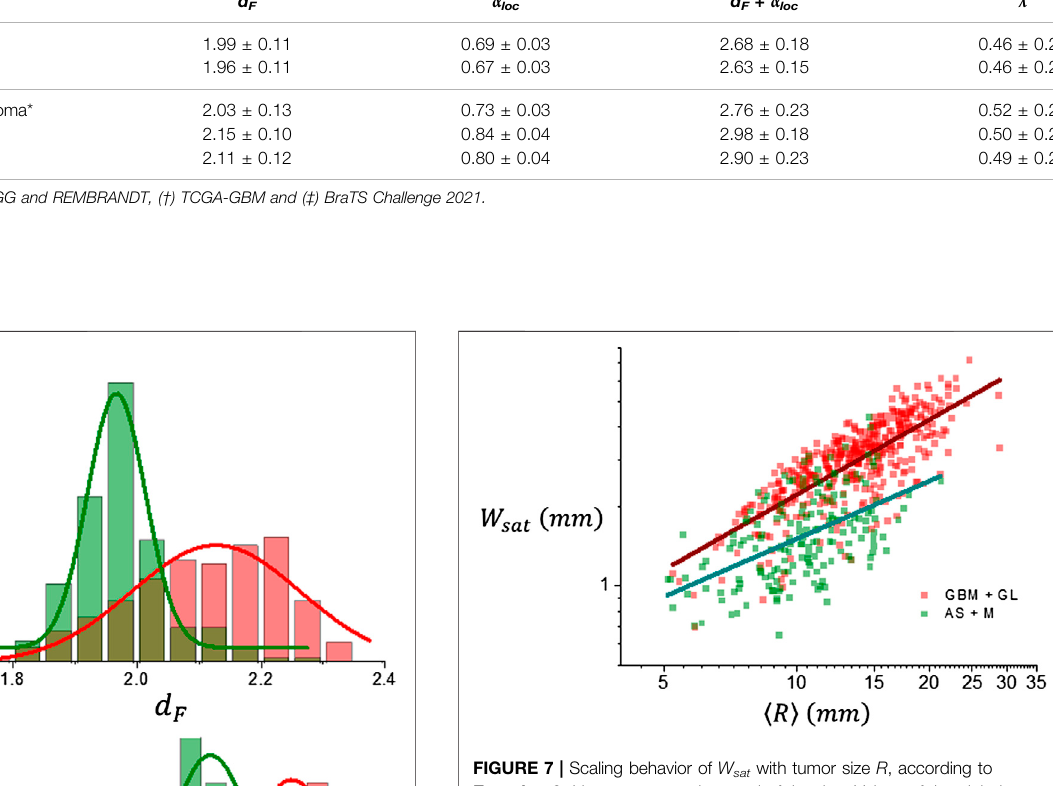
FIGURE 7 | Scaling behavior of W sat with tumor size R , according to Equation 9 . Lines represent the trend of the data Values of the global roughness exponent α are 0.74 ± 0.09 for meningiomas and acoustic schwannomas (AS + M) and 0.94 ± 0.04 for high grade gliomas and glioblastoma multiforme (GBM + GL).